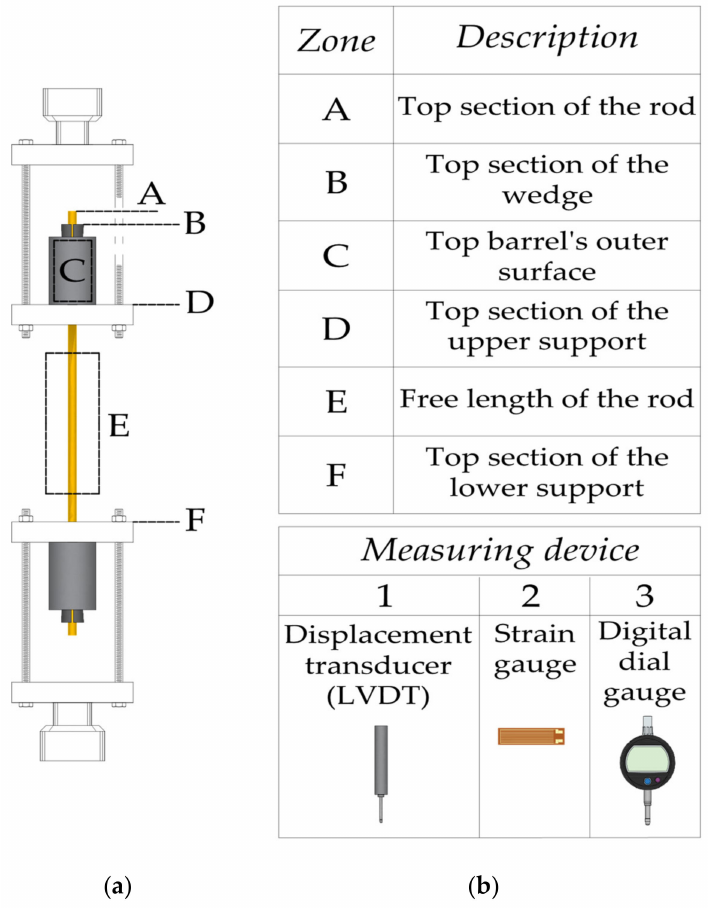
Figure 15. Literature experimental tests on split wedge anchorages—Monitored zones: ( a ) Detail of zones on the anchorage system and a typical test setup; ( b ) Description of the monitored zone and adopted measuring